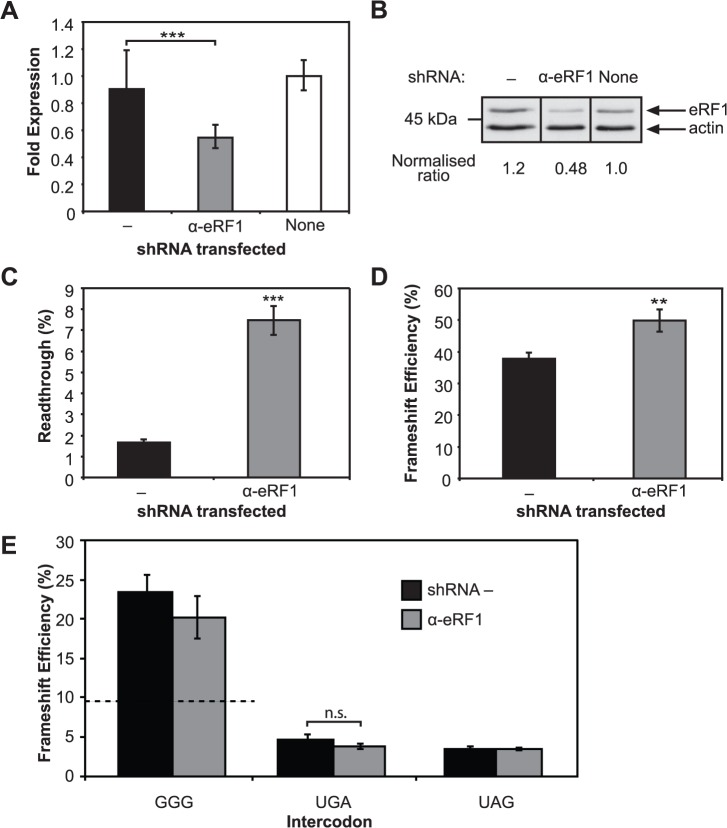
The effect of eRF1 depletion on termination and recoding.A. eRF1 transcript levels measured using quantitative real-time PCR. Results show eRF1 transcripts within RNA isolated from non-transfected HEK293T cells (‘none’), and eRF1 transcripts within RNA isolated from those transfected with α-eRF1 or negative control (−) vectors containing shRNAs. The mean ± standard deviation (SD) for six replicates is shown. B. Immunoblot of eRF1 in protein extracts from non-transfected HEK293T cells (‘none’), or cells transfected with α-eRF1 or negative control (−) vectors containing shRNAs. The ratios were calculated after normalisation to β-actin in each case and compared with the non-transfected control (1.0). Raw data is available in S1 Fig. C. Readthrough at a UGA test context (UGACAG). A dual luciferase construct with the two reporters in the same frame and the test stop signal separating them was co-transfected with the control and α-eRF1 shRNAs. Readthrough at the test stop signal was determined in each case (α-eRF1 and − control.) The mean ± SEM for 12 replicates from three individual experiments is shown. D. Effect of depletion of eRF1 on +1 frameshift efficiency at the human antizyme frameshift element. The mean ± SEM for eight replicates is shown. E. Effect of eRF1 depletion on frameshifting with the native GGG intercodon and substituted stop codon (UGA or UAG). The mean ± SEM for a minimum of 10 replicates from at least two independent experiments is shown. A dotted line indicates the level of −1 PRF in the absence of any shRNA (see Fig. 2). **P = < 0.01, ***P = < 0.001, n.s., not significant.